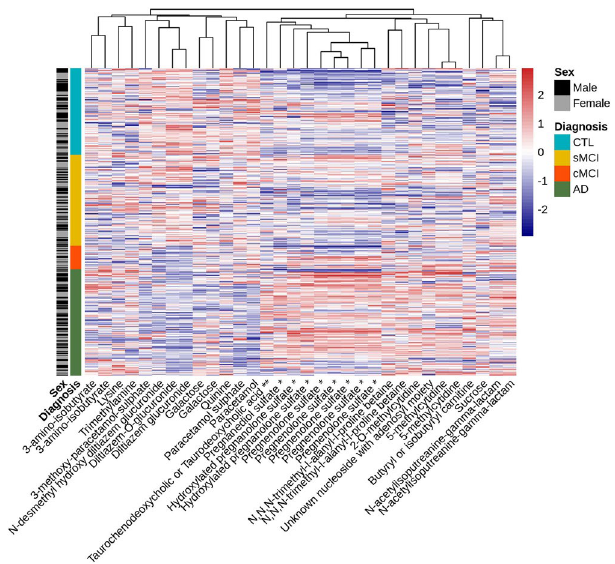
Figure 4. The heatmap showing concentrations of the annotated metabolic features. Note (*) indicates metabolite conjugation with N-acetylglucosamine, note (**) indicates metabolite conjugation with N-acetylglucosaminide. Columns sharing the same metabolite names are isomers of each